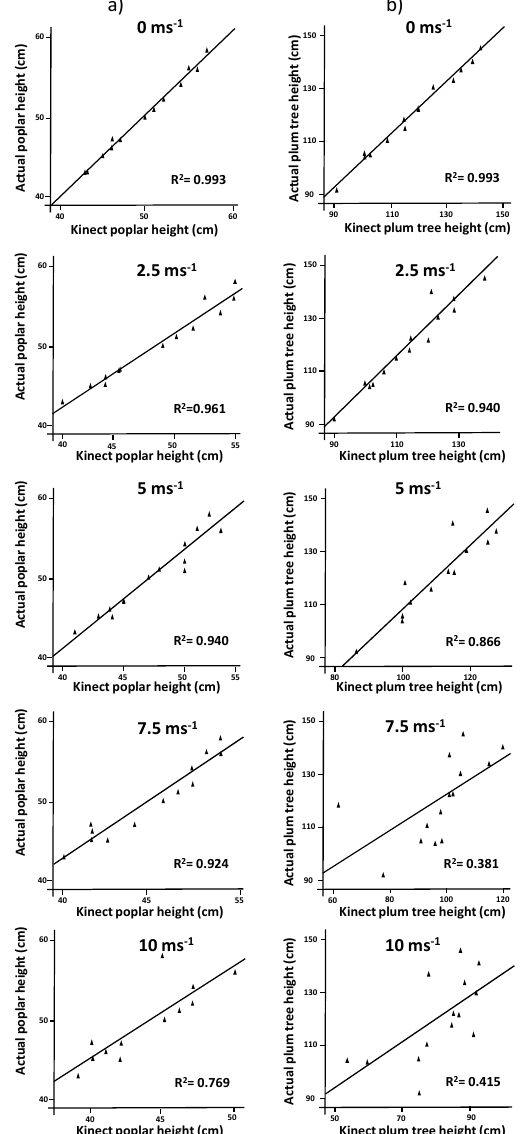
Figure 4. Regression analysis comparing actual height vs. model height for ( a ) poplar trees and ( b ) plum trees at wind speeds ranging from 0 to 10 m·s − 1 .